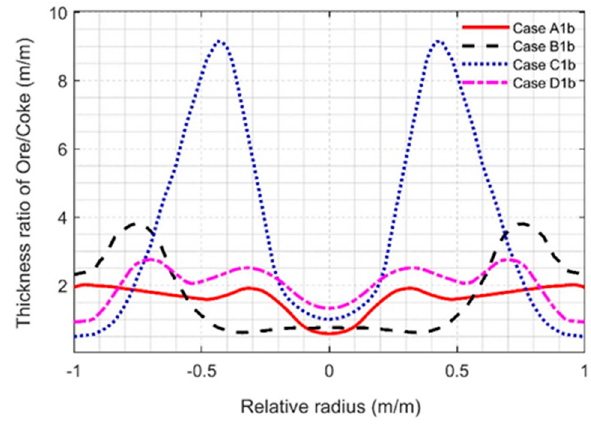
Figure 10. Ore / coke thickness ratio distribution of Cases Figure 10. Ore/coke thickness ratio distribution of Cases A1b–D1b. Figure 10. Ore/coke thickness ratio distribution of Cases A1b–D1b.